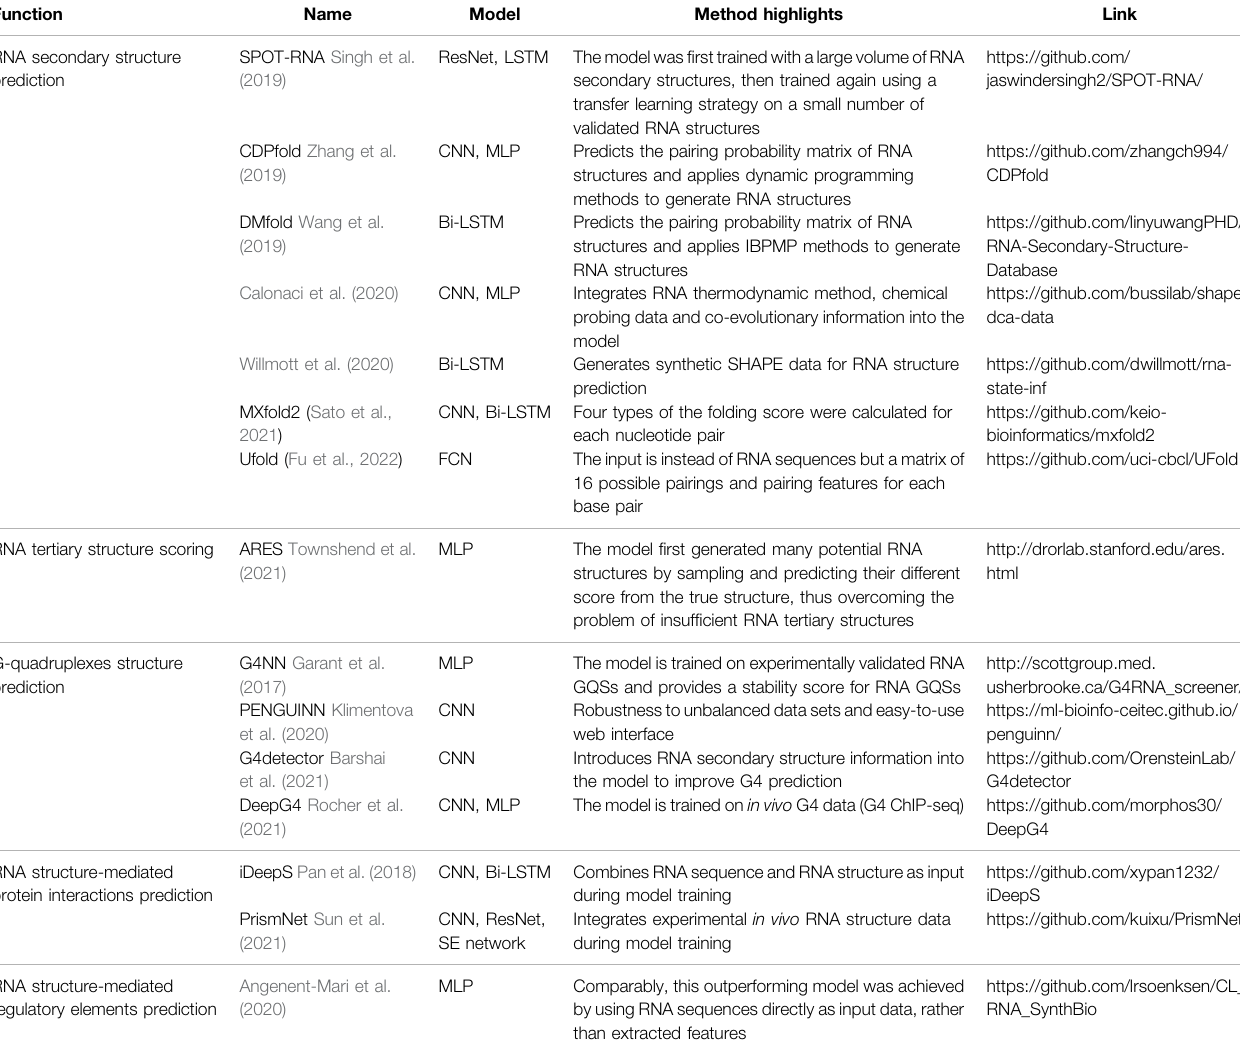
TABLE 1 | Deep learning-based models in RNA structure.